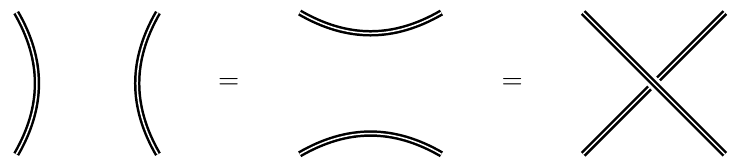
Figure 1 . A graphical depiction of the map from T Z to T b . On the right we have the partition 2 function of T Z on a three-dimensional manifold, equipped with a Z 2 (cid:13)at connection. We represent 2 the connection as a collection of domain walls implementing Z 2 symmetry transformations g , g 0 , etc. On the left we have the partition function of T b , obtained by summing the T Z partition function 2 over all possible choices of Z 2 (cid:13)at connection.